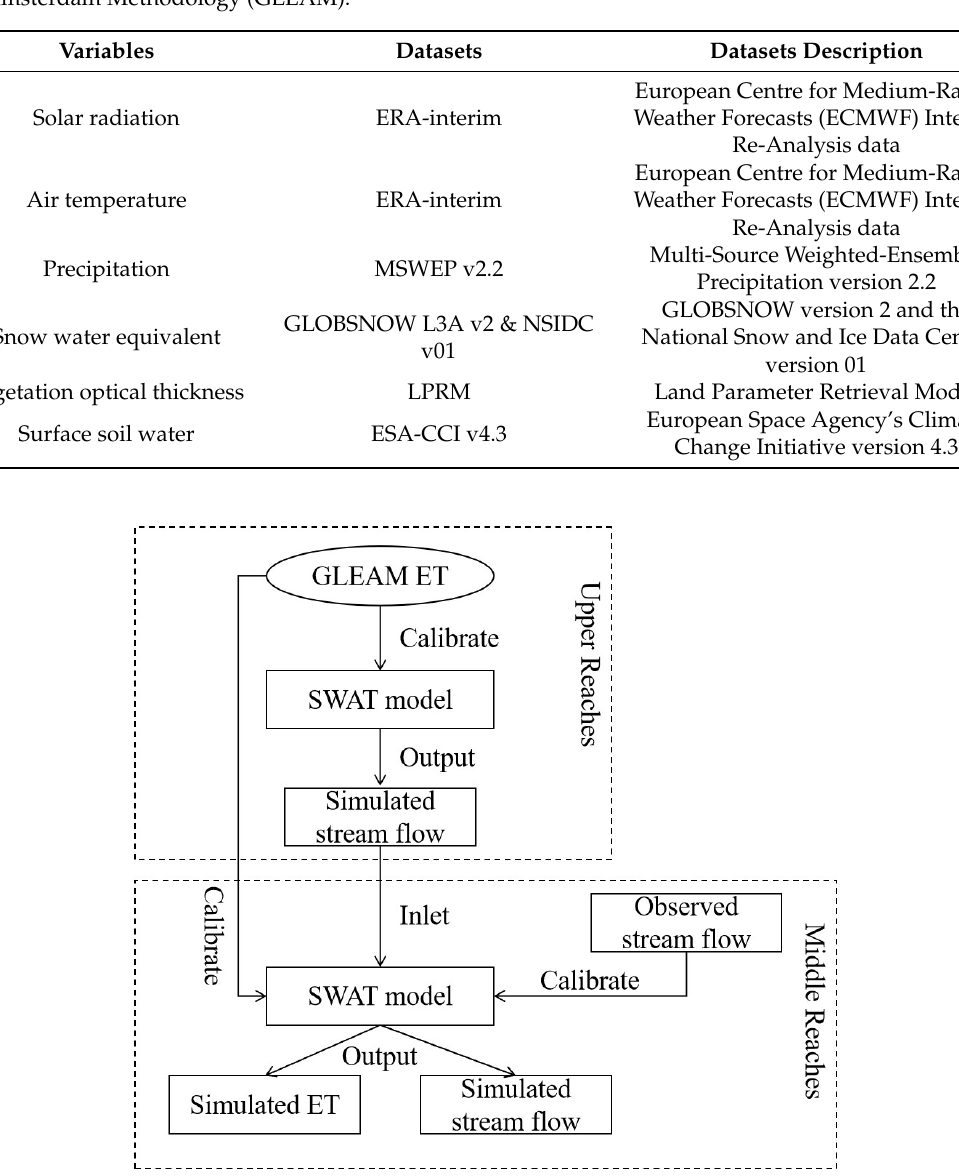
Figure 3. Soil and Water Assessment Tool (SWAT) model calibration strategy. ET: evapotranspiration; GLEAM: Global Land surface Evaporation Amsterdam Methodology.